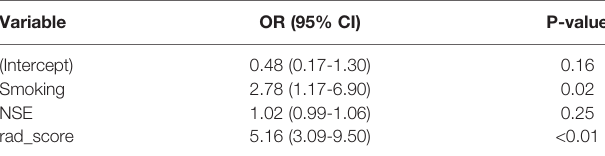
TABLE 4 | Positive results of multivariate logistic regression analysis for the classi fi cation of low and high Ki-67 lung